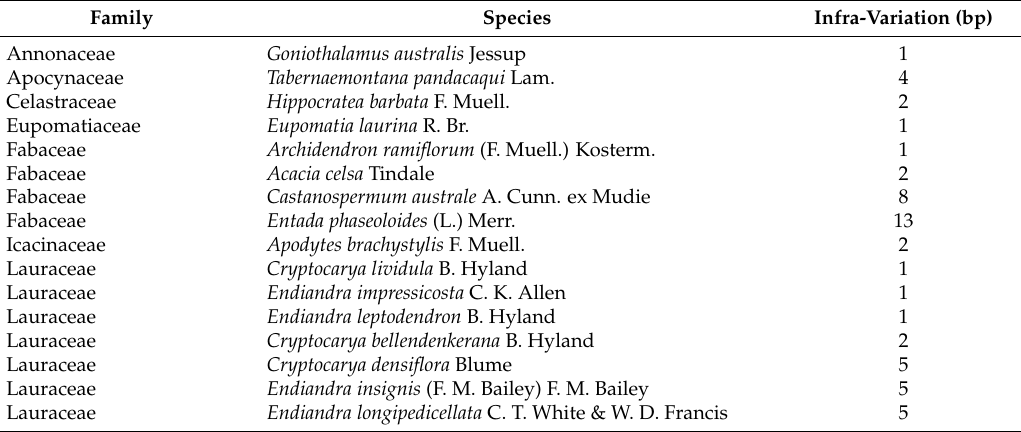
Table 3. List of species showing infraspecific variation across the Black Mountain Corridor. Infraspecific variation (column 3) tallied by total number of base pair (bp) differences within each species across all three barcode